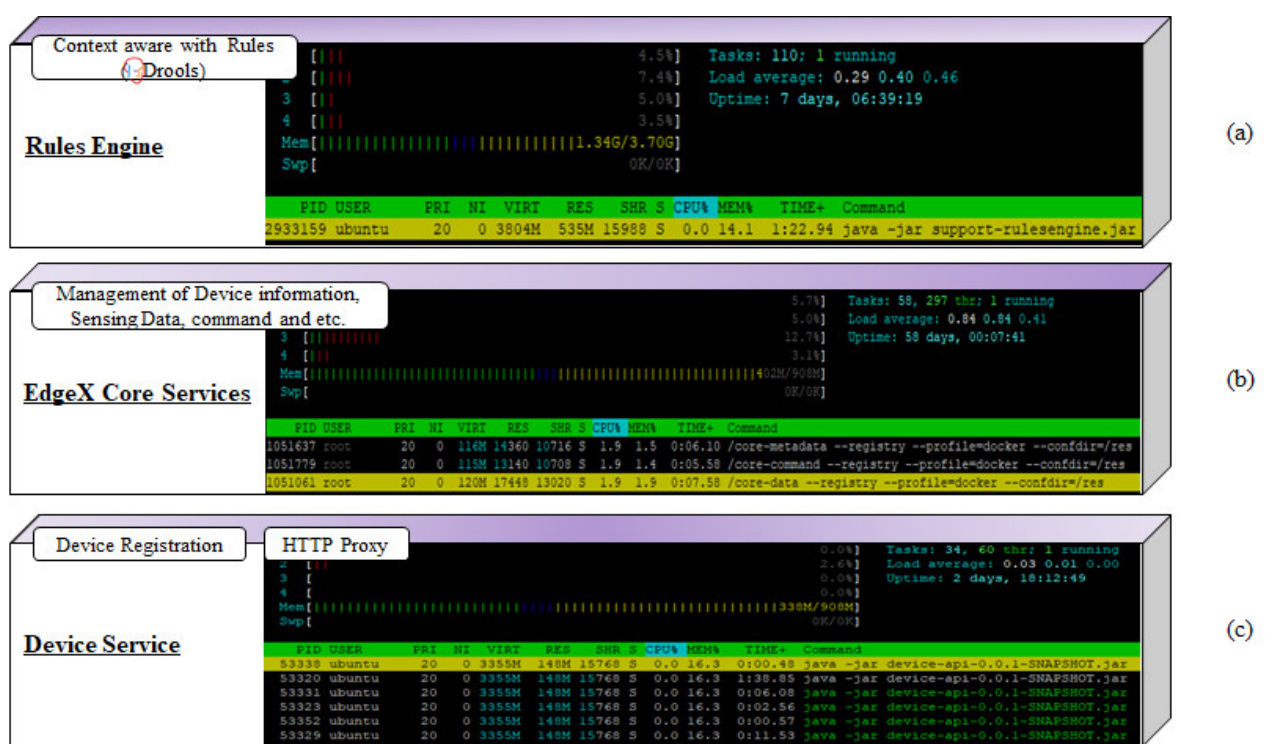
Figure 11. Implemented Rules Engine and Device Service microservices of the proposed embedded edge